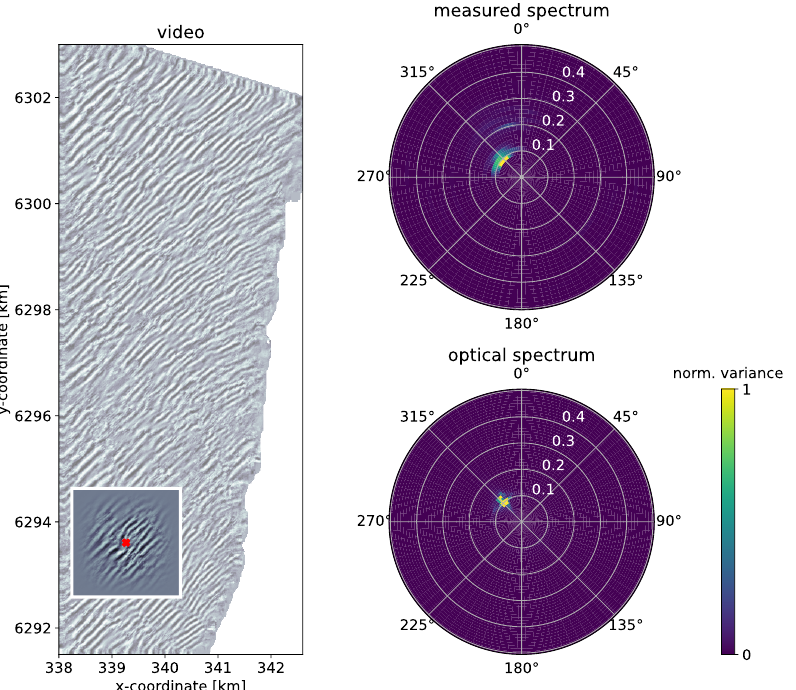
Figure 3. Comparison of an in situ measured ( left , red ‘x’) variance density spectrum from a local buoy ( top right ) against a corresponding optical variance density spectrum from reconstructed satellite video ( bottom right ) of a representative area (2km × 2km) around the buoy location ( left , white box). Both spectra are normalized to unit magnitude for comparison.